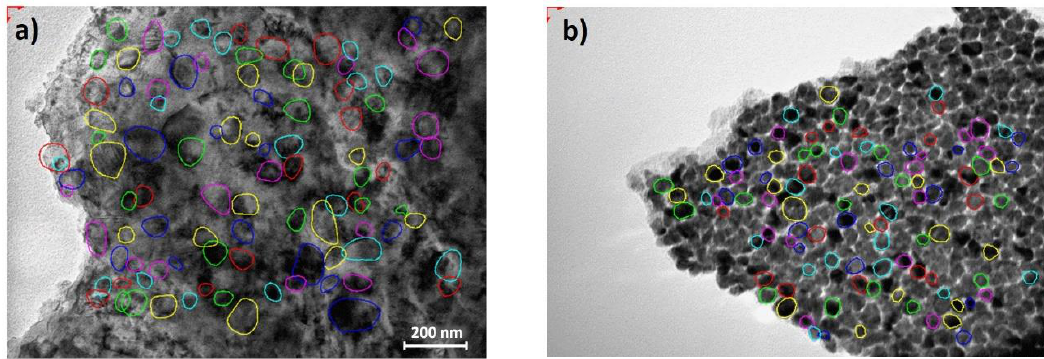
Figure 9. HRTEM images of Pt/Si ( a ) and PtTi/Si ( b ) as the sample start point for measuring the mean size of grain on this sample.